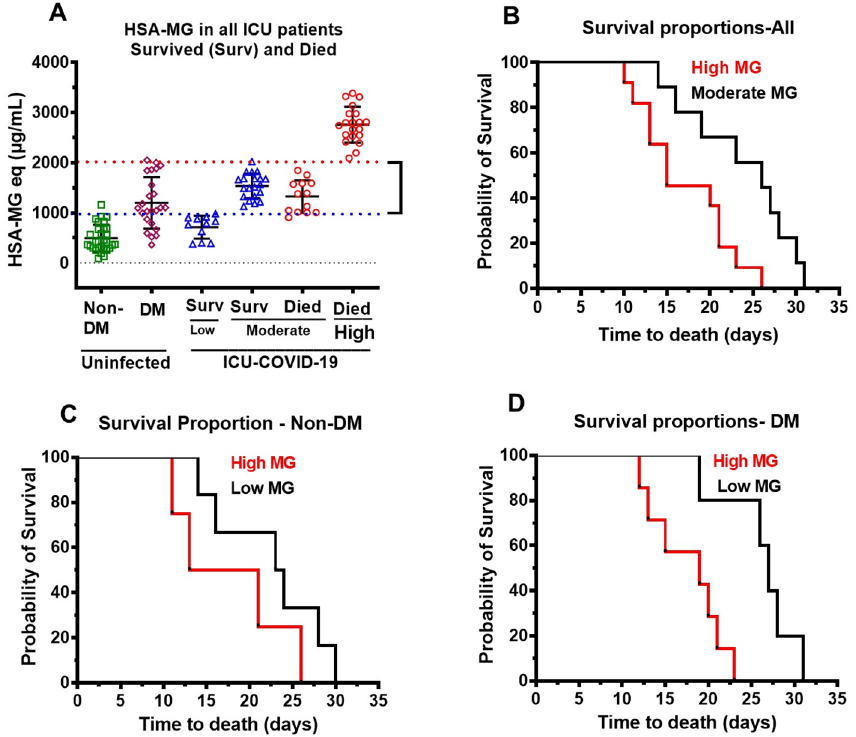
Figure 9. Kaplan–Meier curves for non-DM and DM ICU COVID-19 patients that died. ( A ) Low MG (< 2 times higher than uninfected non-DM), moderate MG (between 2 and 3 times higher than uninfected non-DM) and high MG (> 4times higher than uninfected non-DM) in ICU patients that survived and died along with MG in uninfected non-DM and DM individuals. Data shown are mean ± S.E.M for each of n = 30 uninfected controls (26.6% females), n = 11 survived for low, and n = 21 survived moderate. n = 13 died for moderate and n = 20 died, for high MG. ( B ) Kaplan–Meier survival curve for all ICU COVID-19 patients that died with moderate MG (n = 13) and high MG (n = 20). ( C ) Kaplan–Meier survival curve for non-DM ICU COVID-19 patients that died with moderate (n = 8) and high MG (n = 8). ( D ) Kaplan–Meier survival curve for DM ICU COVID-19 patients that died with moderate (n = 5) and high MG (n =